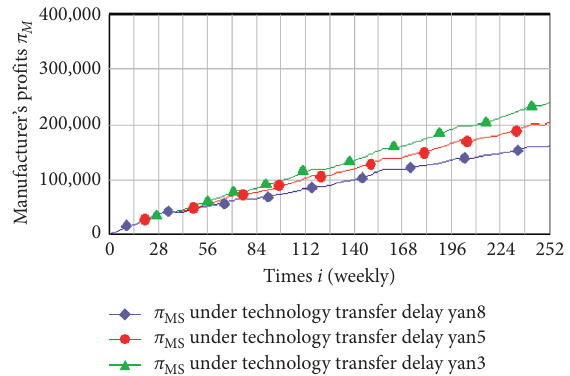
Figure 5: The impact of transfer core technology delay on the manufacturer’s long-term profit.